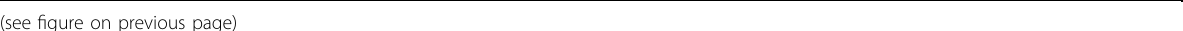
Fig. 2 FeTPPS selectively inhibits recombinant HMGB1-mediated caspase-11 activity in vitro. A , B Production of IL-1 α , IL-1 β , TNF α , and IL-6 (as measured by ELISA) of WT or Casp11 − / − peritoneal macrophages stimulated with LPS alone (1 μ g/mL) or LPS (1 μ g/mL) + HMGB1 (400 ng/mL) in the absence or presence of indicated doses of FeTPPS for 16h. Data presented as mean±SD of technical replicates. **** P < 0.0001 (unpaired t-test ). C Western blots for IL-1 α , caspase-11, and caspase-1 in the supernatants or GSDMD-NT, caspase-11, IL-1 α , IL-1 β , caspase-1 in the cell lysates from WT or Casp11 − / − peritoneal macrophages stimulated with LPS alone (1 μ g/mL) or LPS (1 μ g/mL) + HMGB1 (400ng/mL) in the absence or presence of indicated doses of FeTPPS for 16h. D Necrotic cell lysate preparation is shown in the left panel. Western blots for HMGB1, IL-1 α , caspase-11, and caspase- 1 in the supernatants or GSDMD-NT, Caspase-11, IL-1 α , IL-1 β , and caspase-1 in the cell lysates from WT or Casp11 − / − peritoneal macrophages stimulated with LPS alone (1 μ g/mL), LPS (1 μ g/mL) + HMGB1 + / + , or HMGB1 − / − MEF cells in the absence or presence of FeTPPS for 16h. E Primary hepatocytes isolated from mice of indicated genotypes co-cultured with WT mouse peritoneal macrophages are shown in the left panel. IL-1a and IL-1 β released from macrophages after the stimulation of LPS (1 μ g/mL) in the absence or presence of FeTPPS are shown in the right panel. Data presented as mean± SD of technical replicates. Two-way ANOVA was used (IL-1 α hmgb1f/f Albcre − LPS vs. LPS + FeTPPS ** P = 0.004; hmgb1f/f Albcre − + LPS vs. hmgb1f/f Albcre + + LPS **** P <0.0001; IL-1 β hmgb1f/f Albcre − LPS vs. LPS + FeTPPS ** P = 0.0025; hmgb1f/f Albcre − + LPS vs. hmgb1f/f Albcre + + LPS **** P < 0.0001). F Production of IL-1 β (as measured by ELISA), Western blots of supernatants and cell lysates to detected IL-1 β , Caspase-1 cleavage from WT or NLRP3 − / − peritoneal macrophages primed with LPS 100ng/mL and indicated stimulation. G Western blots for IL-1 α , caspase-4 (Casp4), GSDMD-NT in the supernatants or cell lysates. LDH assay and ELISA for IL-1 α in the supernatants of PMA-primed human monocytic THP-1 cells transfected with scrambled siRNA or CASP4-speci fi c siRNA upon HMGB1 (400ng/mL) and LPS (1 μ g/mL) stimulation in the absence or presence of FeTPPS. Data presented as mean± SD of technical replicates. An unpaired t -test (two-sided) was used (LDH LH vs. LH + FeTPPS 2.5 μ M ** P = 0.0085; LH vs. LH + FeTPPS 5 μ M ** P = 0.0071; LH scramble vs. LH casp4 siRNA ** P = 0.0043; IL-1 α LH vs. LH + FeTPPS 2.5 μ M * P = 0.0328; LH vs. LH + FeTPPS 5 μ M * P = 0.0198; LH scramble vs. LH casp4 siRNA *** P = 0.004). Graphs are representative of at least three independent